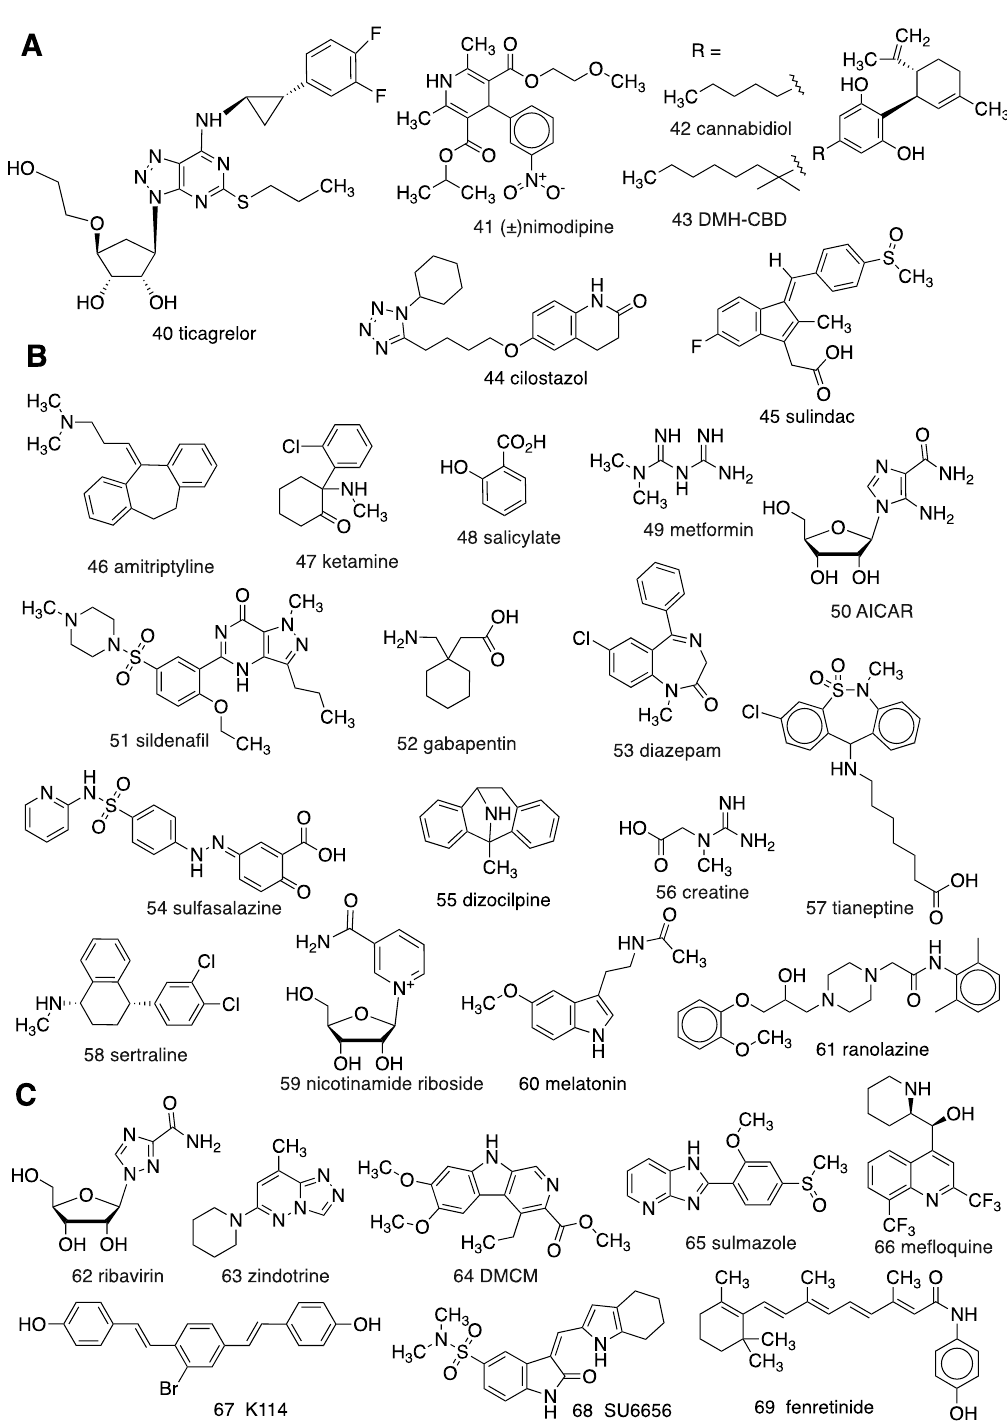
Figure 3. Structures of diverse drugs suggested to have an unanticipated involvement of adenosinergic signaling in their MoA: ( A ) By modulating adenosine transport; ( B ) by unclear mechanisms; ( C ) by direct AR interaction.